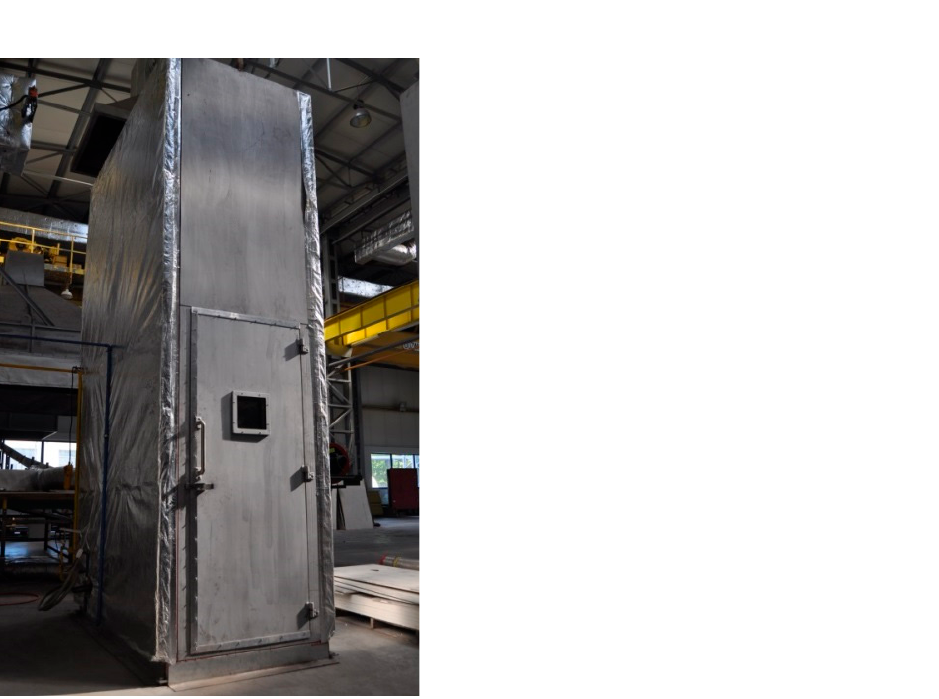
Figure 2. External view test chamber at the accredited ITB Fire Testing Laboratory in Pionki, Poland.